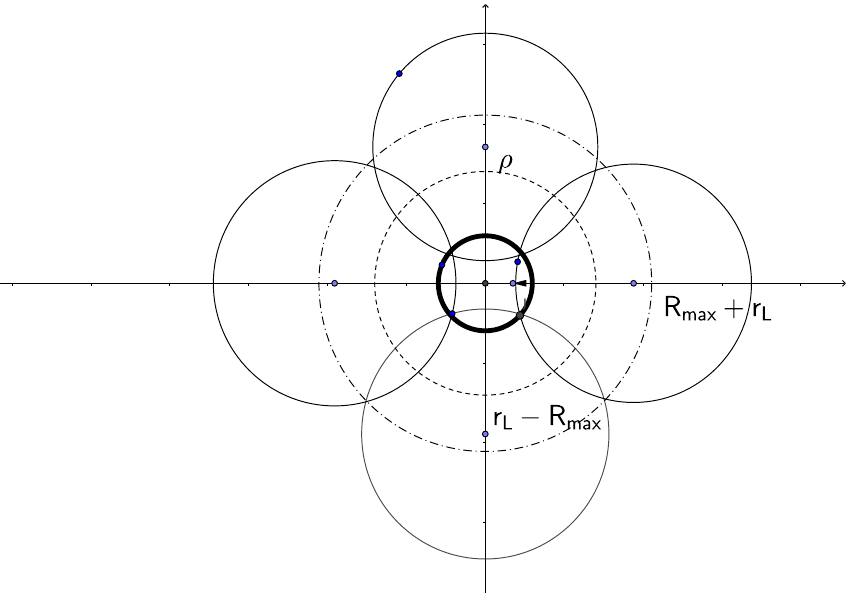
Figure 3. The shaded area shows the difference ψ − θ that satisfies Equation (6).